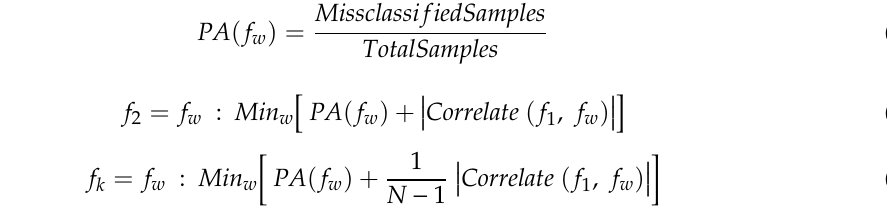
Table 1. Optimized fused hybrid-feature selection table (POE + AC).